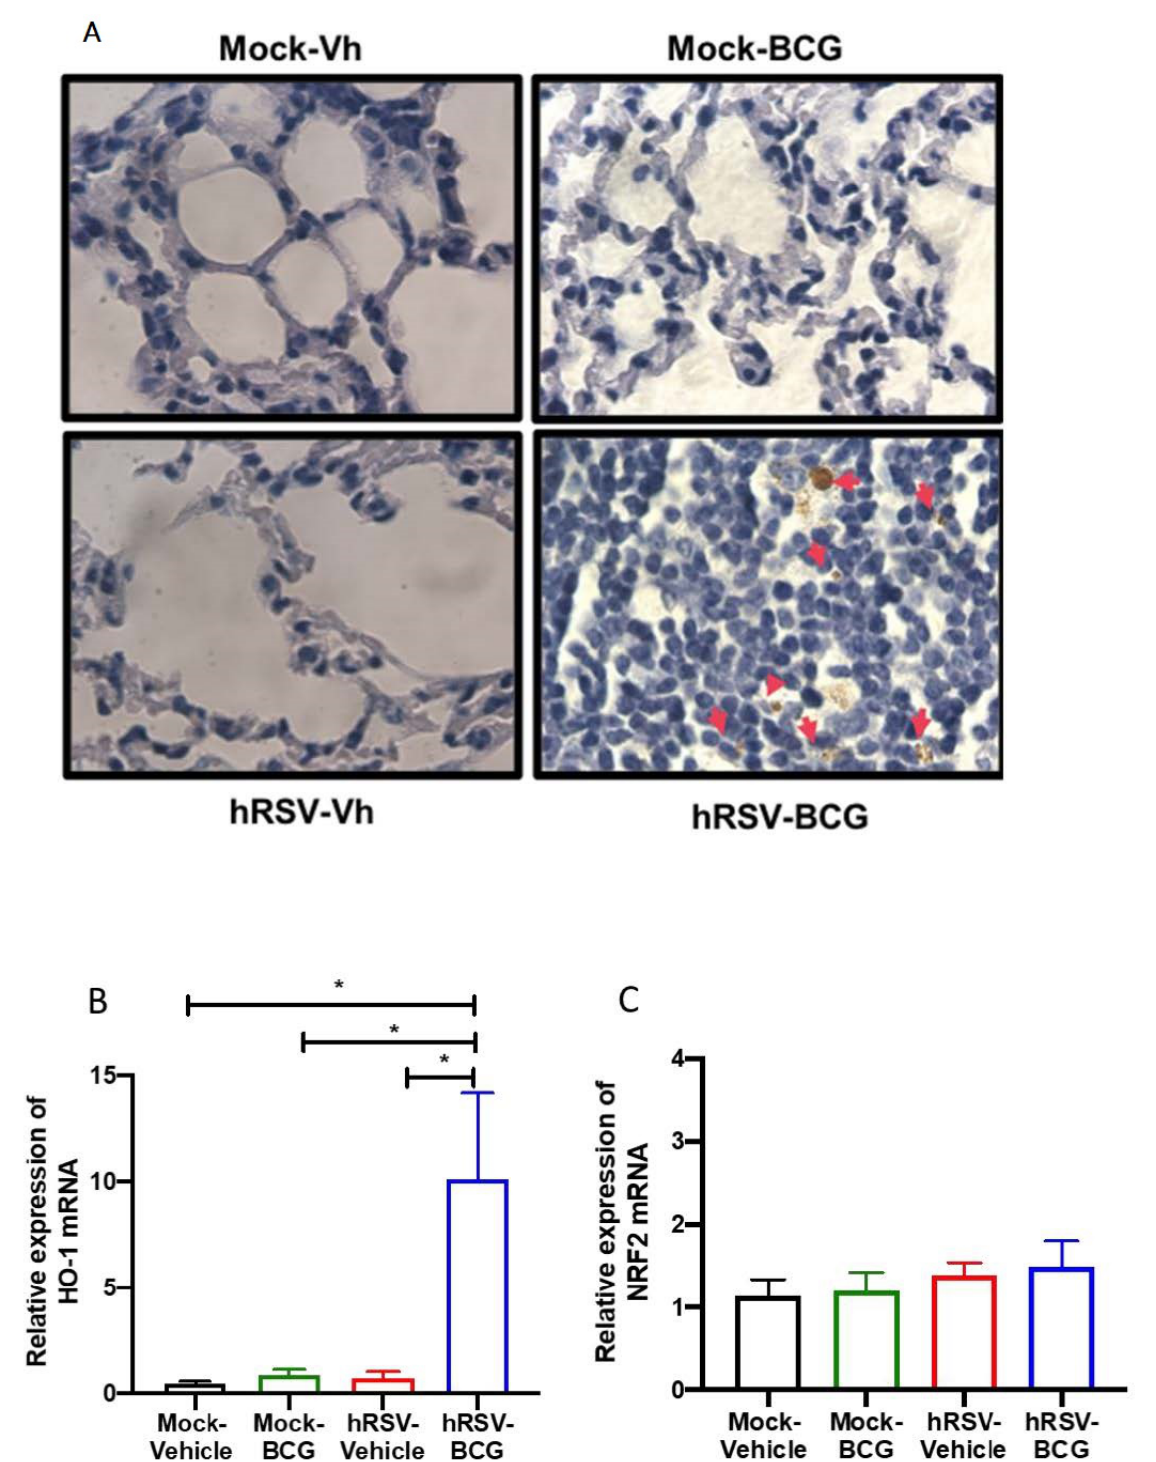
Figure 3. Determination of mycobacteria and Heme Oxygenase (HO)-1 activity during a short infection scheme with the human respiratory syncytial virus (hRSV) and Bacillus Calmette-Guerin (BCG). ( A ) Acid-fast staining of Mycobacterium bovis -infected mouse lungs collected on day 11 post-inoculation with BCG (100 × magnification). Quantification by real-time quantitative reverse transcription polymerase chain reaction (RT-qPCR) of ho-1 ( B ) and the nuclear factor E2-related factor 2 ( nrf2 ) ( C ). Data are shown as means ± SEM of three independent experiments with 3–4 animals per group. One-way ANOVA was performed with a post-hoc Tukey test (* p < 0.05).